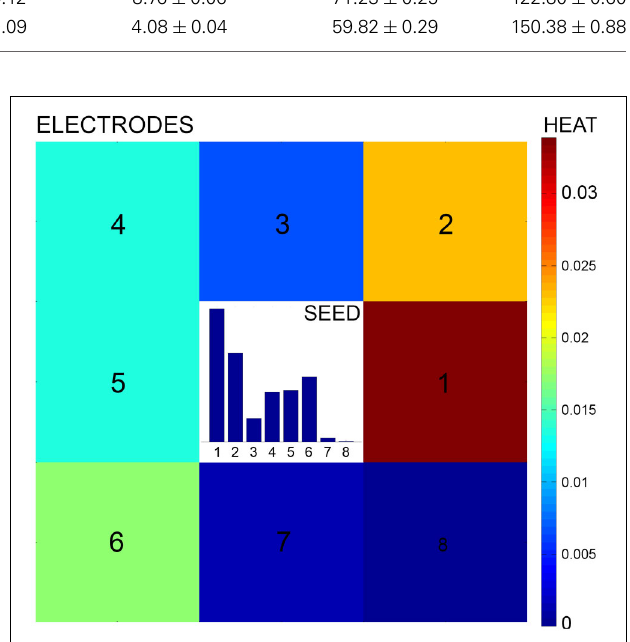
FIGURE 2 | Heat propagation. A heat source is placed at the seed electrode and propagated according to the probability of connection defined by the directional feature. Heat propagation favors directions with higher probability of connection. The adjacent electrodes (numbered from 1 to 8) are reached by a different amount of heat according to the seed feature, as described by the